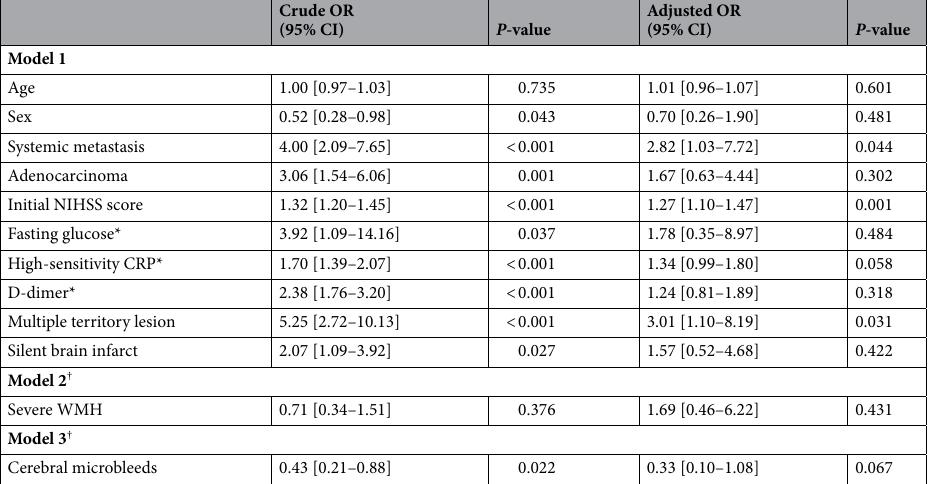
Table 4. Multivariable logistic regression analysis to evaluate the effects of cerebral small vessel disease on unfavorable outcome (mRS 3–6). mRS = modified Rankin Scale, NIHSS = National Institutes of Health Stroke Scale, CRP = c-reactive protein, WMH = white matter hyperintensity. *These variables were transformed using a log scale. † Adjusted for age and P < 0.05 in univariate analysis (sex, systemic metastasis, adenocarcinoma, initial NIHSS score, fasting glucose, high-sensitivity CRP, D-dimer, and multiple territory lesion).